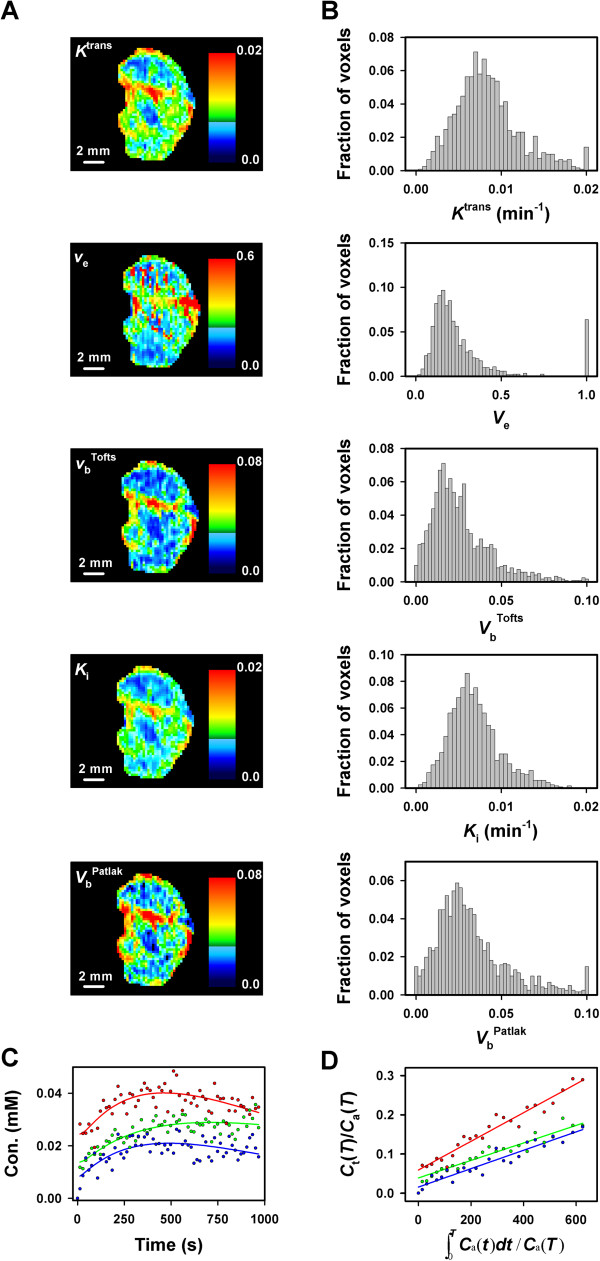
DCE-MRI data for CK-160 cervical carcinoma xenografts imaged with gadomelitol as contrast agent. (A) The parametric images of Ktrans, ve, VbTofts, Ki, and VbPatlak of a representative tumor. (B) The Ktrans, ve, VbTofts, Ki, and VbPatlak frequency distributions of the same tumor. (C) Gadomelitol concentration versus time for three representative single voxels of the same tumor. The curves were fitted to the data by using the Tofts pharmacokinetic model. (D) Ct(T)/Ca(T) versus ∫Ca(t)dt/Ca(T) for the same three voxels. The curves were fitted to the data by using the Patlak pharmacokinetic model.